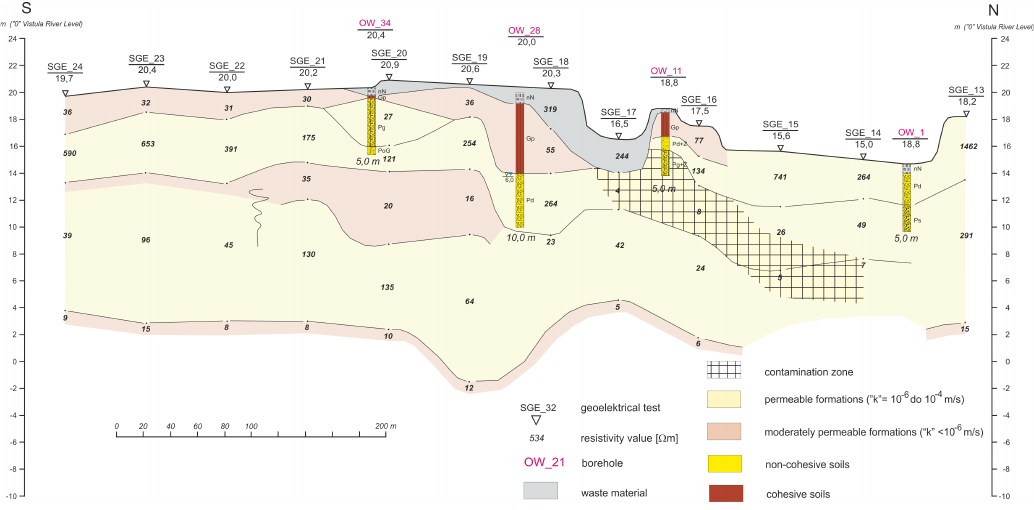
Figure 9. Geophysical cross-section of the landfill subsoil—Section I.